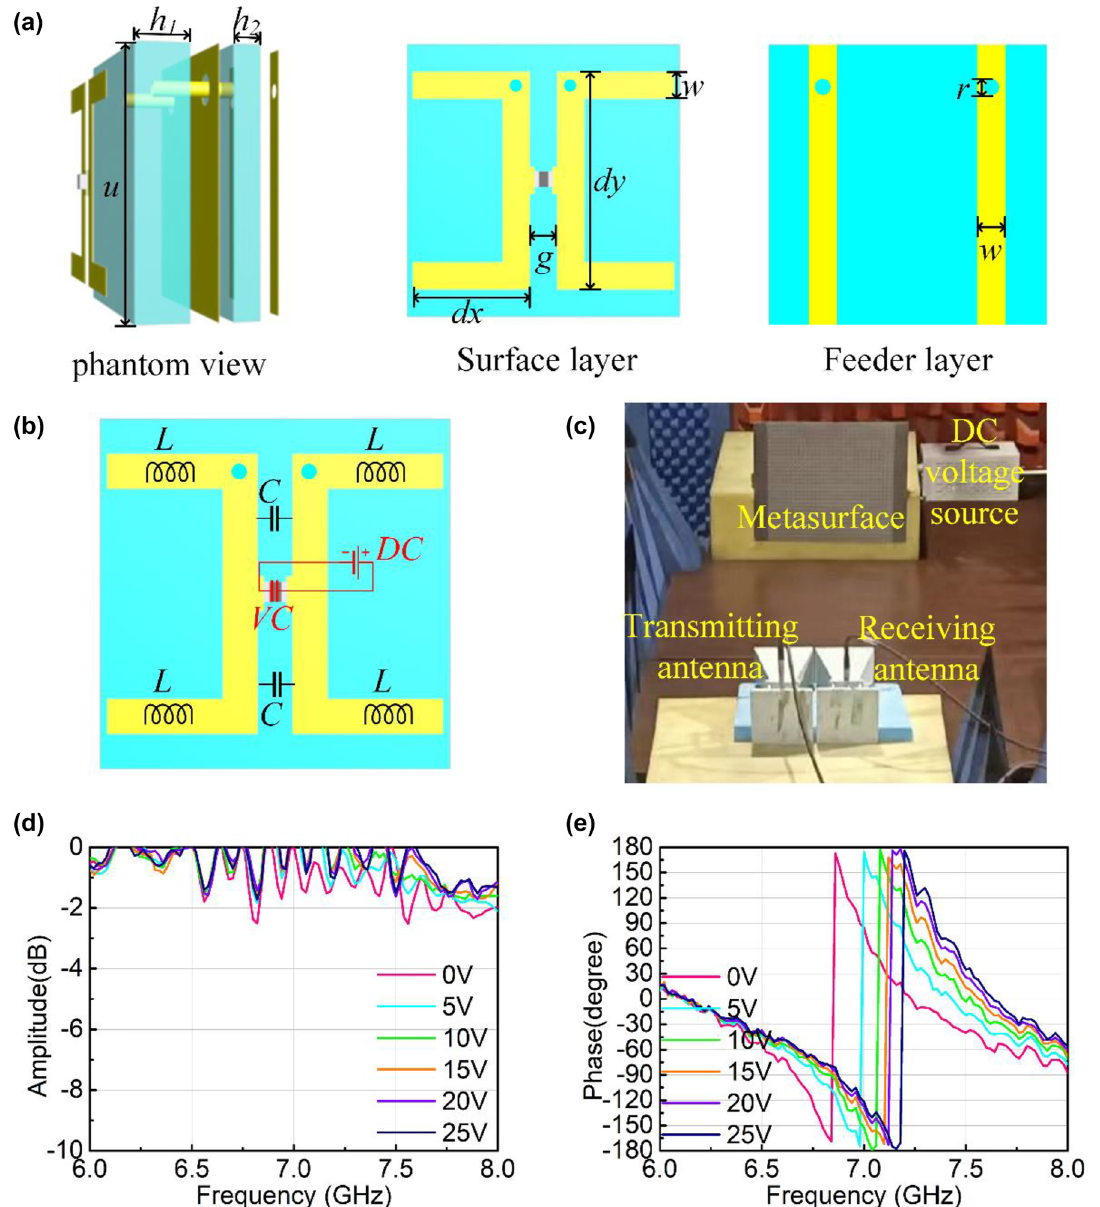
Figure 2: Coding meta-atom with PIN diode: (a) structure and geometrical parameters of the meta-atom; (b) equivalent circuits of the meta-atom; (c) S-parameters measured environment; (d) measured reflectivity response at different voltages; and (e) measured phase response at different voltages.